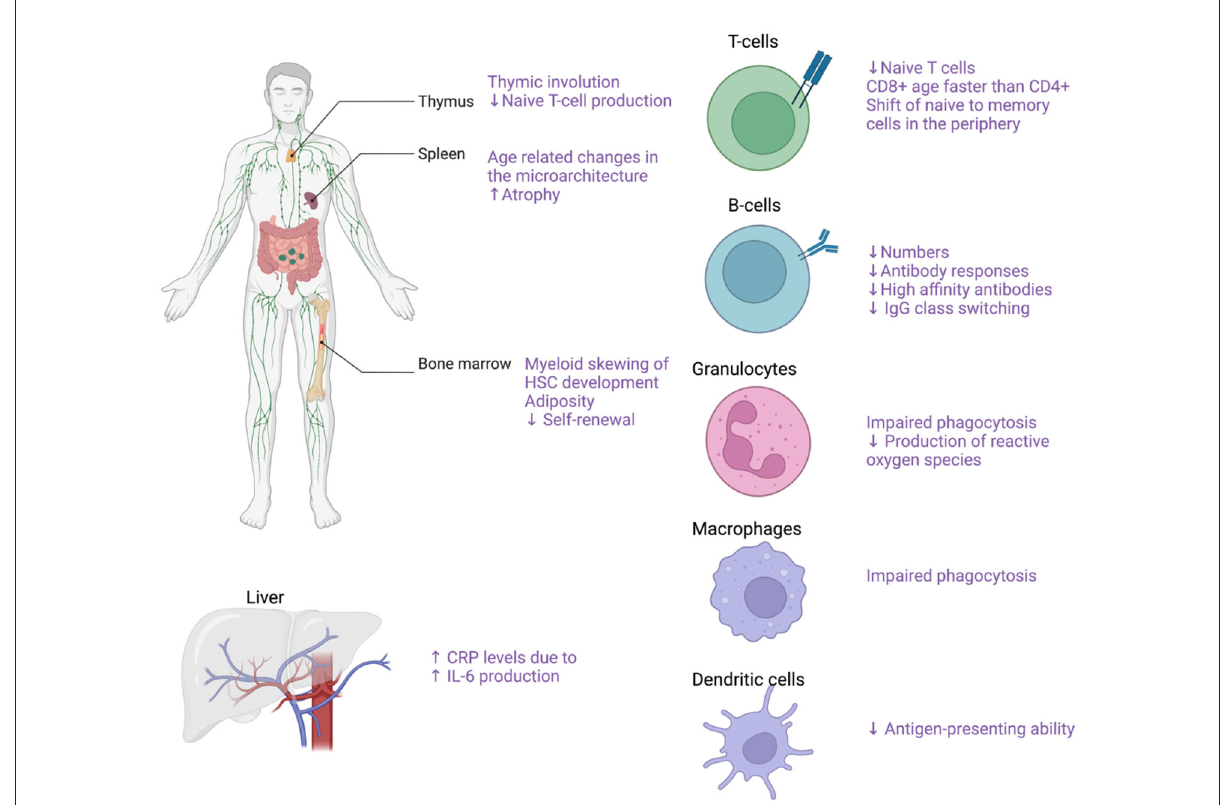
FIGURE5 Effects of aging on the immune system. Effects of aging on the immune system with focus on the main cellular populations contributing to GCA pathogenesis. Created with